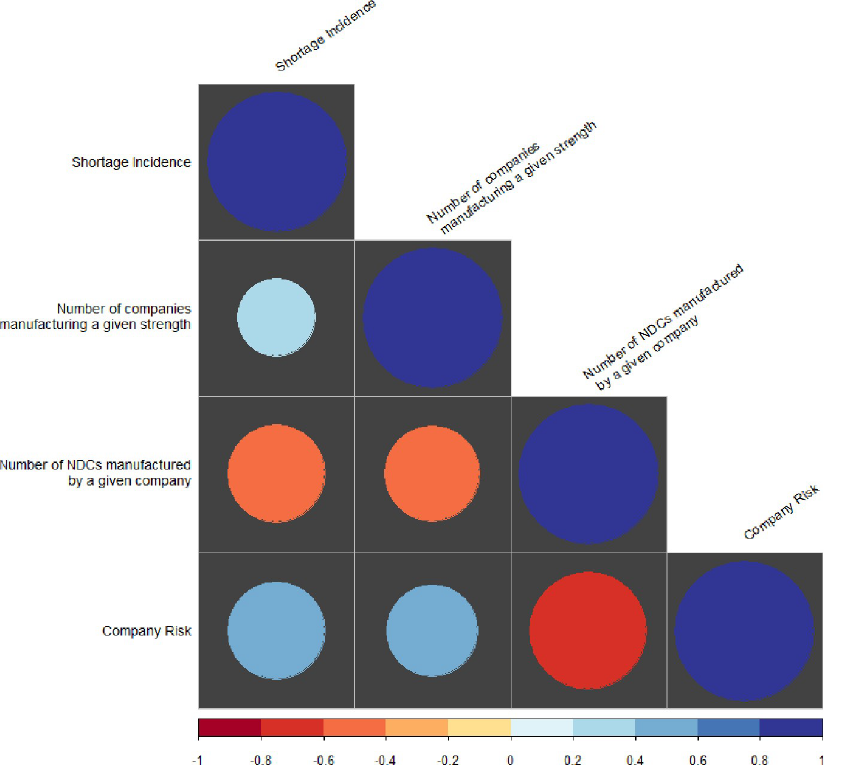
Fig 2. Kendall’s tau correlation coefficients for predictors of